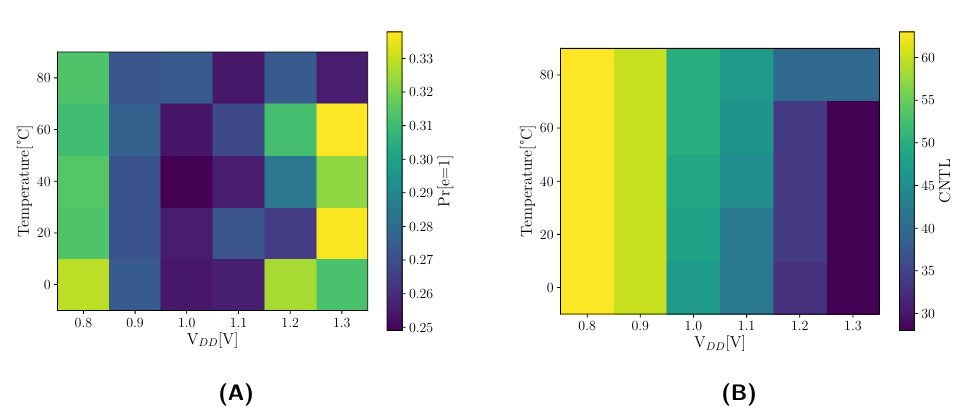
Figure 10: Probability of error (A) and value of the 6-bit CNTL signal (B) after the calibration phase, in function of the power supply voltage and working